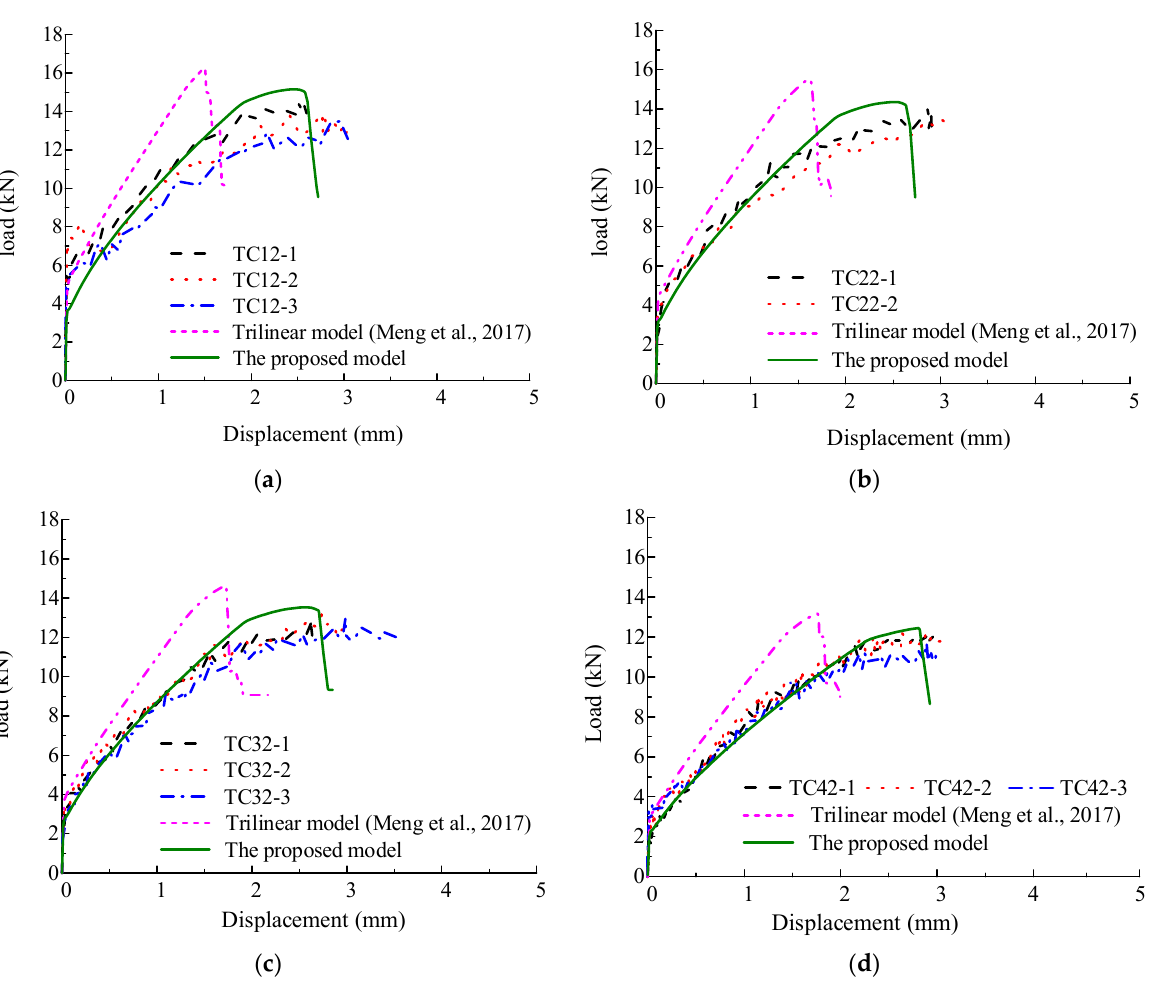
Figure 8. Comparison of tensile load-displacement curves of HSSWR reinforced ECC: ( a ) TC-1 group; ( b ) TC-2 group; ( c ) TC-3 group; ( d ) TC-4 group [23–25].